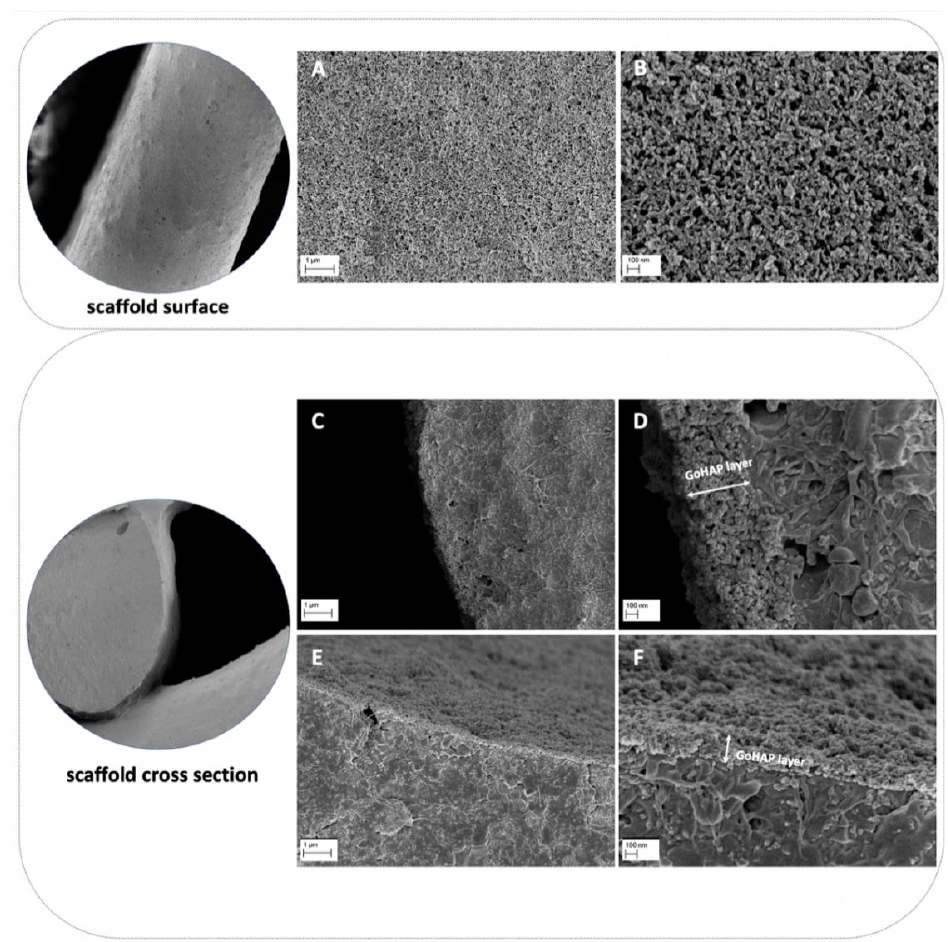
Figure 2. SEM images of the obtained nano-hydroxyapatite GoHAP layers on nHAP-coated PCL/HAP/β -TCP scaffolds: ( A , B ) outer fiber surface of the scaffold; ( C – F ) cross-section of the inner fibers of the scaffold.